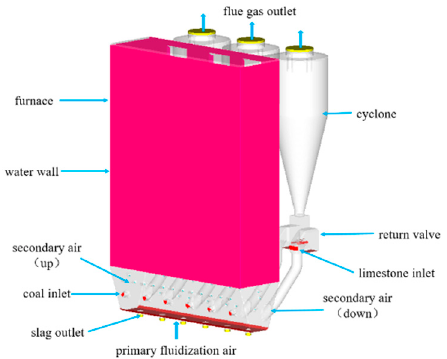
Figure 6. Full circuit model of the CFB boiler.